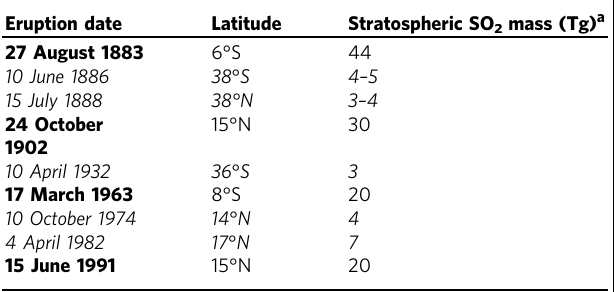
Fig. 9 Composite regional responses to strong and weak eruptions of the late 19th and 20th centuries. Anomalies in 2-m air temperature and 10-m winds from NOAA ’ s 20th century reanalysis for eruptions after 1880 (Table 2) for a JFM and c JJA in the year after the four strongest eruptions ( a , c ) and fi ve weaker eruptions ( b -JFM, d -JJA). Anomalies are computed by removing decadal and longer time series using the decadal fi lter described in ref. 47 , a step necessitated by the transient background state, and temperature anomalies are plotted only where they exceed 95% signi fi cance (assessed using a Monte- Carlo technique). The dissimilarities in the fi elds, particularly in the Arctic, suggest it may be inappropriate to include weaker eruptions in a composite for the purposes of model validation, as the variability they contain is unlikely to be strongly forced